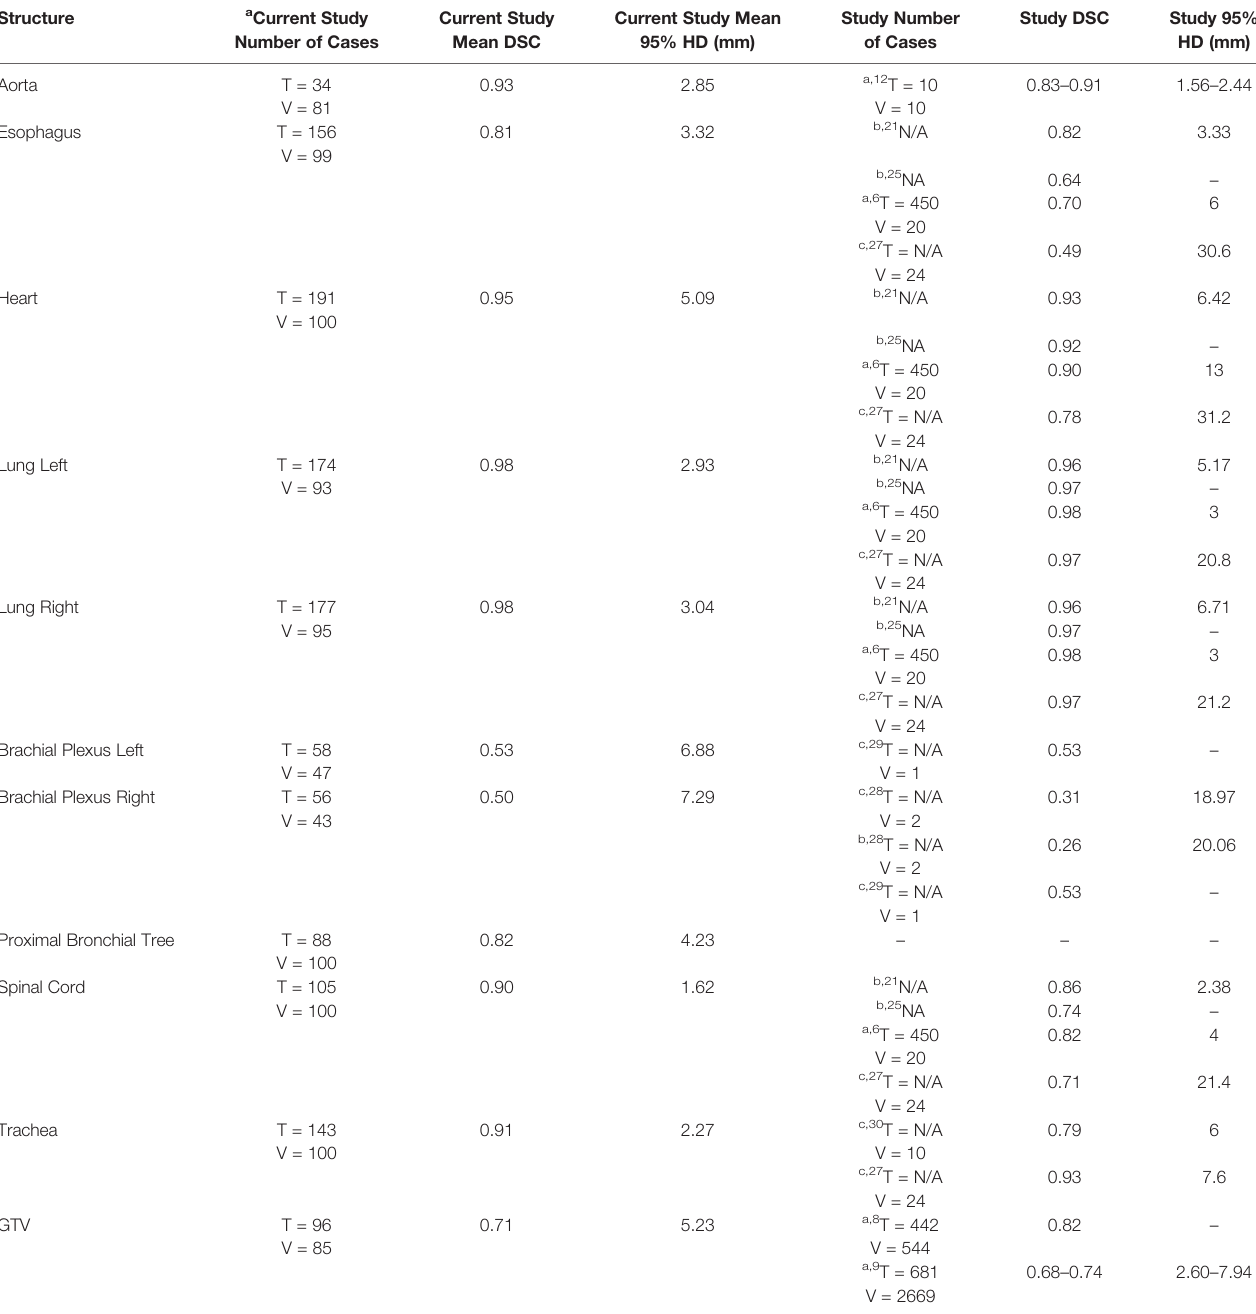
TABLE 3 | Summary of Dice Similarity Coef fi cient (DSC) and 95% Hausdorff distance (HD) metrics for lung stereotactic ablative radiotherapy planning structures from the current study and other studies.